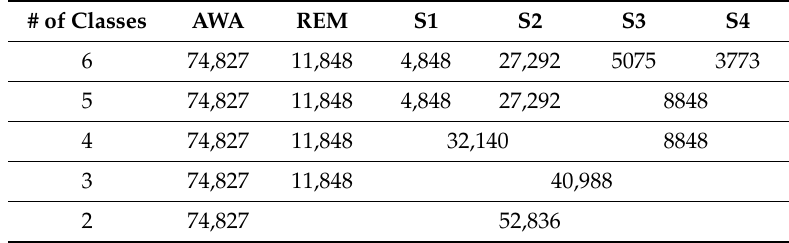
Table 2. The number of samples in Sleep-EDF dataset (R & K